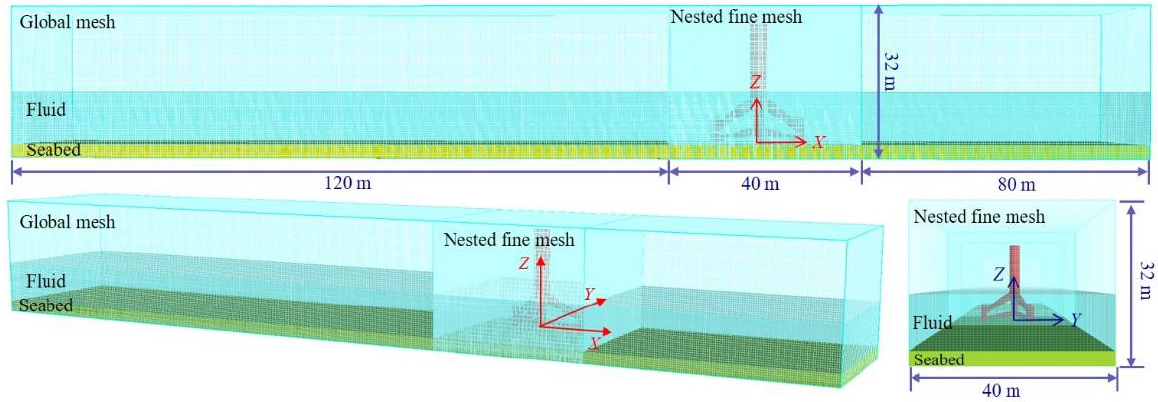
Figure 2. A sketch of the mesh block.